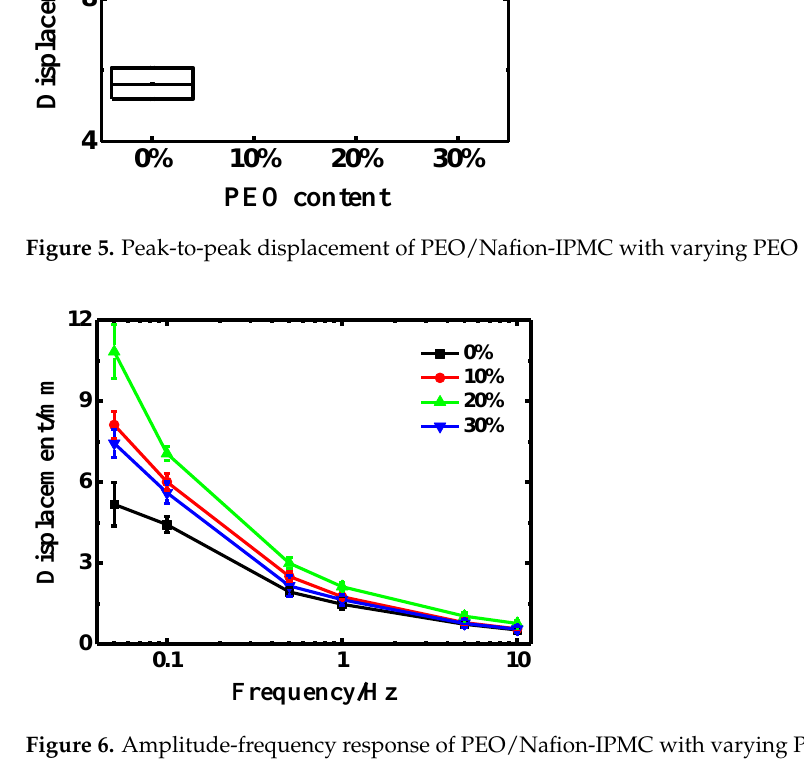
Figure 5. Peak − to − peak displacement of PEO/Nafion − IPMC with varying PEO contents.